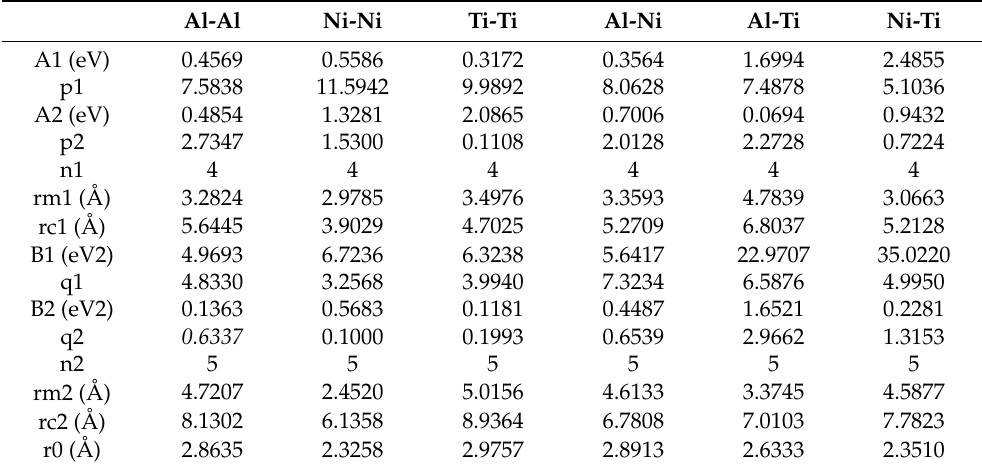
Table 1. Potential parameters of the TB-SMA model for the Al-Ni-Ti system. Al-Al Ni-Ni Ti-Ti Al-Ni Al-Ti